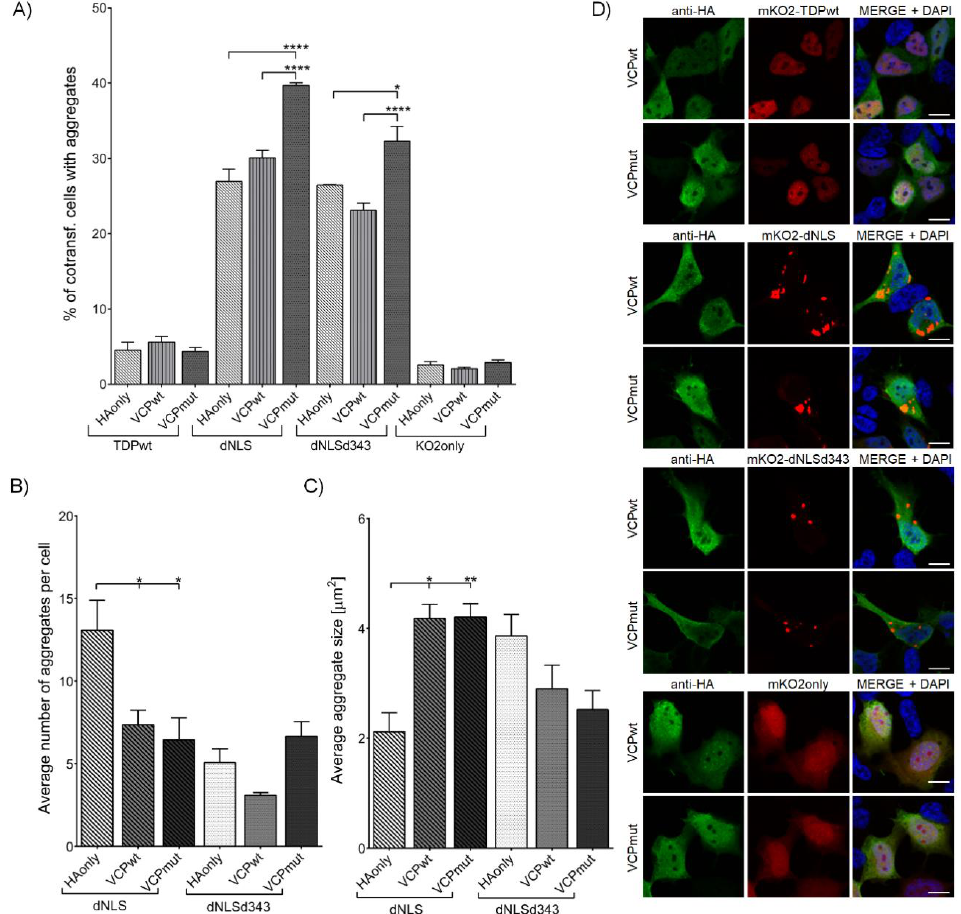
Figure 4. SH-SY5Y cells co-transfected with mKO2 constructs and wt or mut VCP. ( A ) Quantification of co-transfected cells harboring aggregates. ( B ) Average number of aggregates in an individual cell. ( C ) Average aggregate size. ( D ) SH-SY5Y cells co-transfected with mKO2 constructs and wt or mut VCP. Probed for HA-tag and counterstained with DAPI. Scale bars: 10 µm.